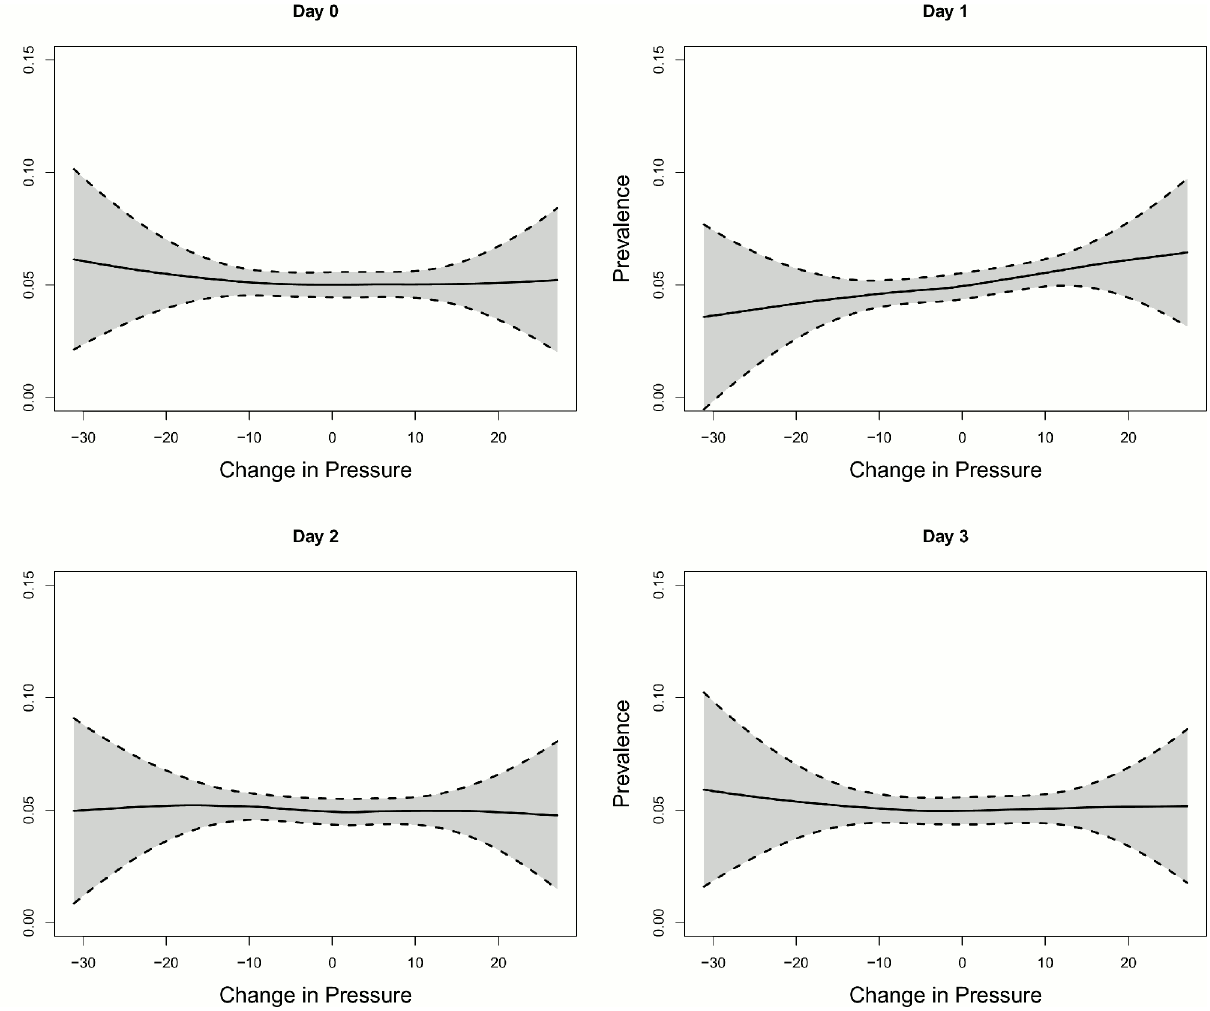
Fig 4. Change in atmospheric pressure versus prevalence of MD episodes. Scatter plot of change in atmospheric pressure DiffPressure in hPa versus prevalence of MD episodes. The black line corresponds to the loess smoother with k = 0.75. No relationship between prevalence of MD episodes and change in air pressure could be observed for air pressure values on day zero, two and three, but a roughly linear increasing relationship was found between the onset of an MD episode and change in air pressure one day before the